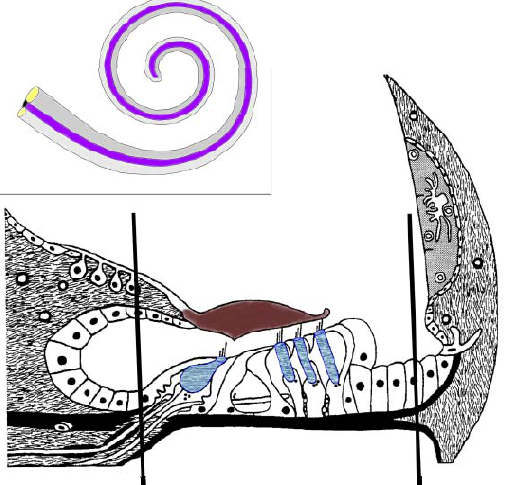
Figure 1. Schematic representation of the cochlear membranous labyrinth and the organ of Corti. A cross section of the cochlea is represented with the hair cells (blue) being depicted with the single inner hair cell and three outer inner hairs. The black lines represent the approximate region isolated by dissection for this proteomic investigation. The framed insert represents the membranous labyrinth of the cochlea with the anterior scala vestibuli (gray), the scala media (cochlear duct) (purple) that contains the organ of Corti and the scala tympani (light